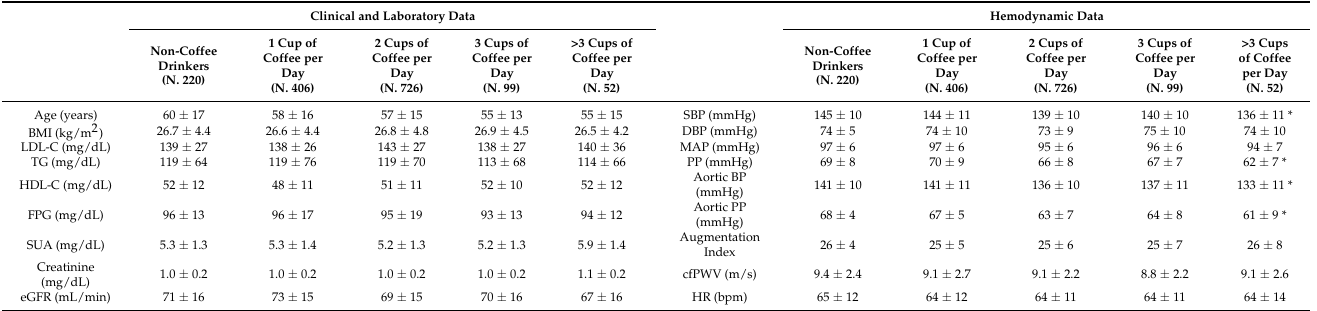
Table 2. Main clinical and laboratory characteristics of the study population by cups of coffee consumed per